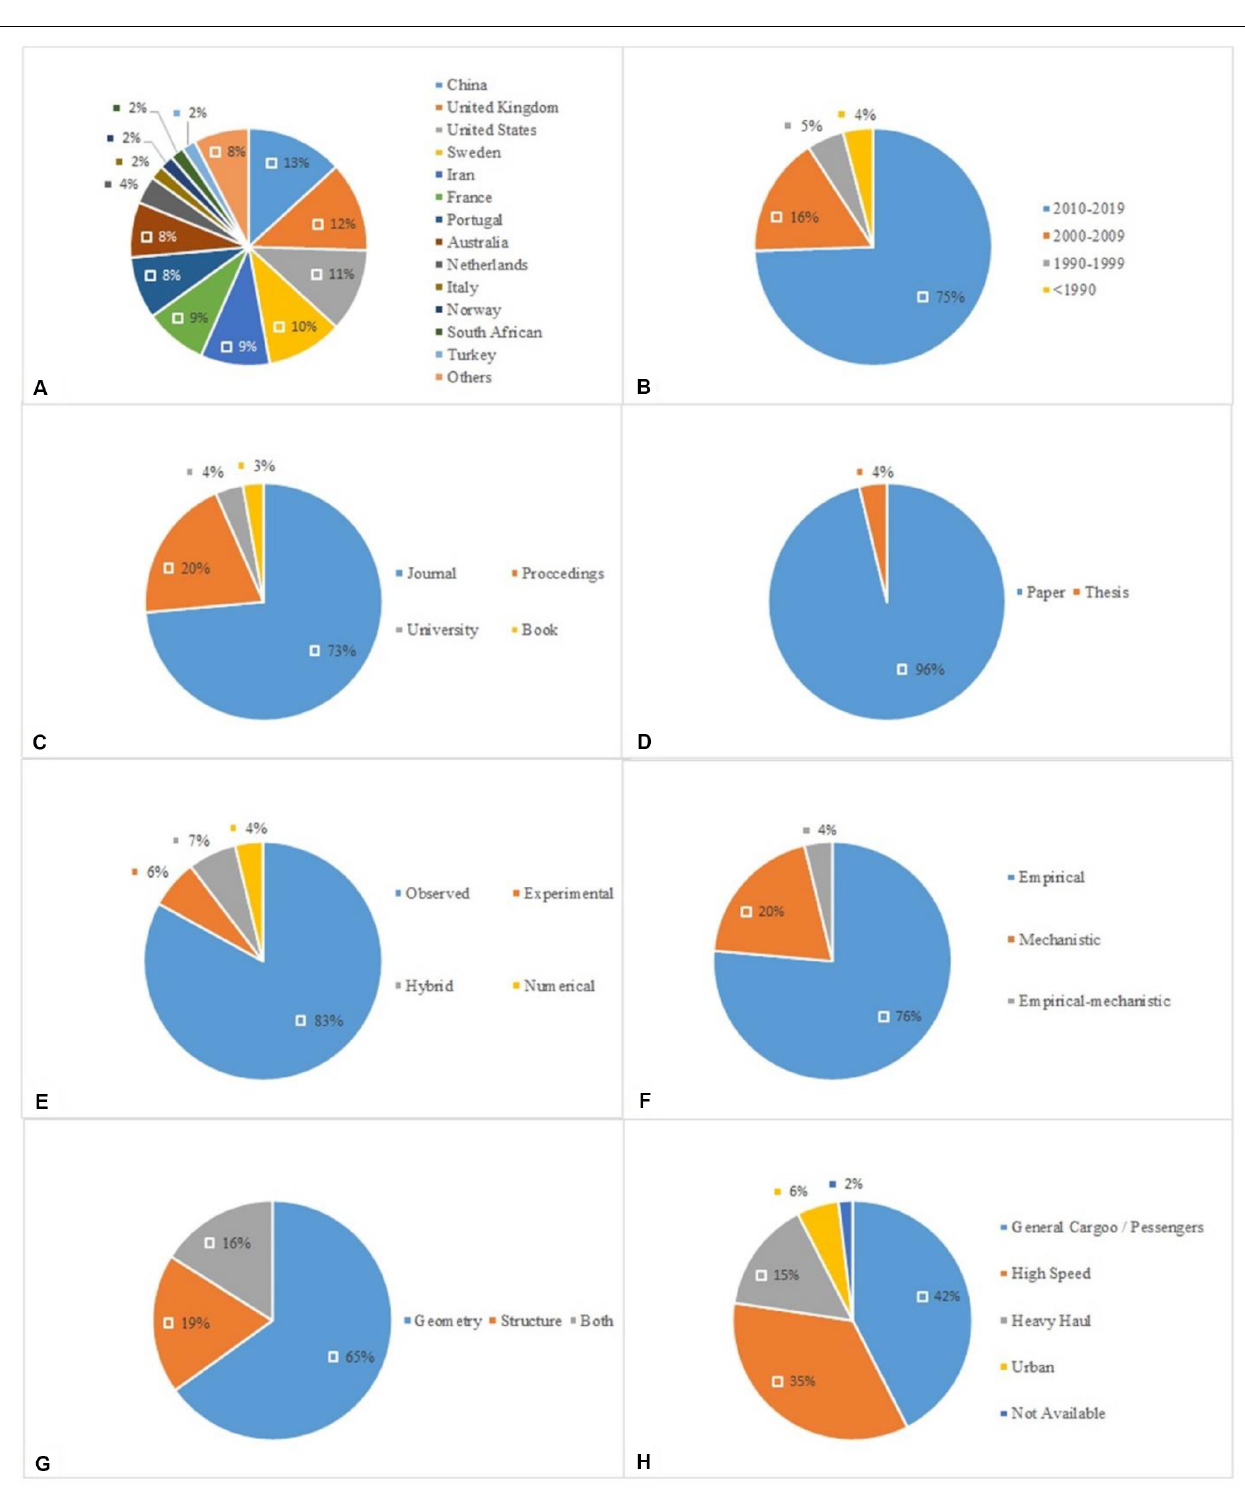
Frontiers in Built Environment |